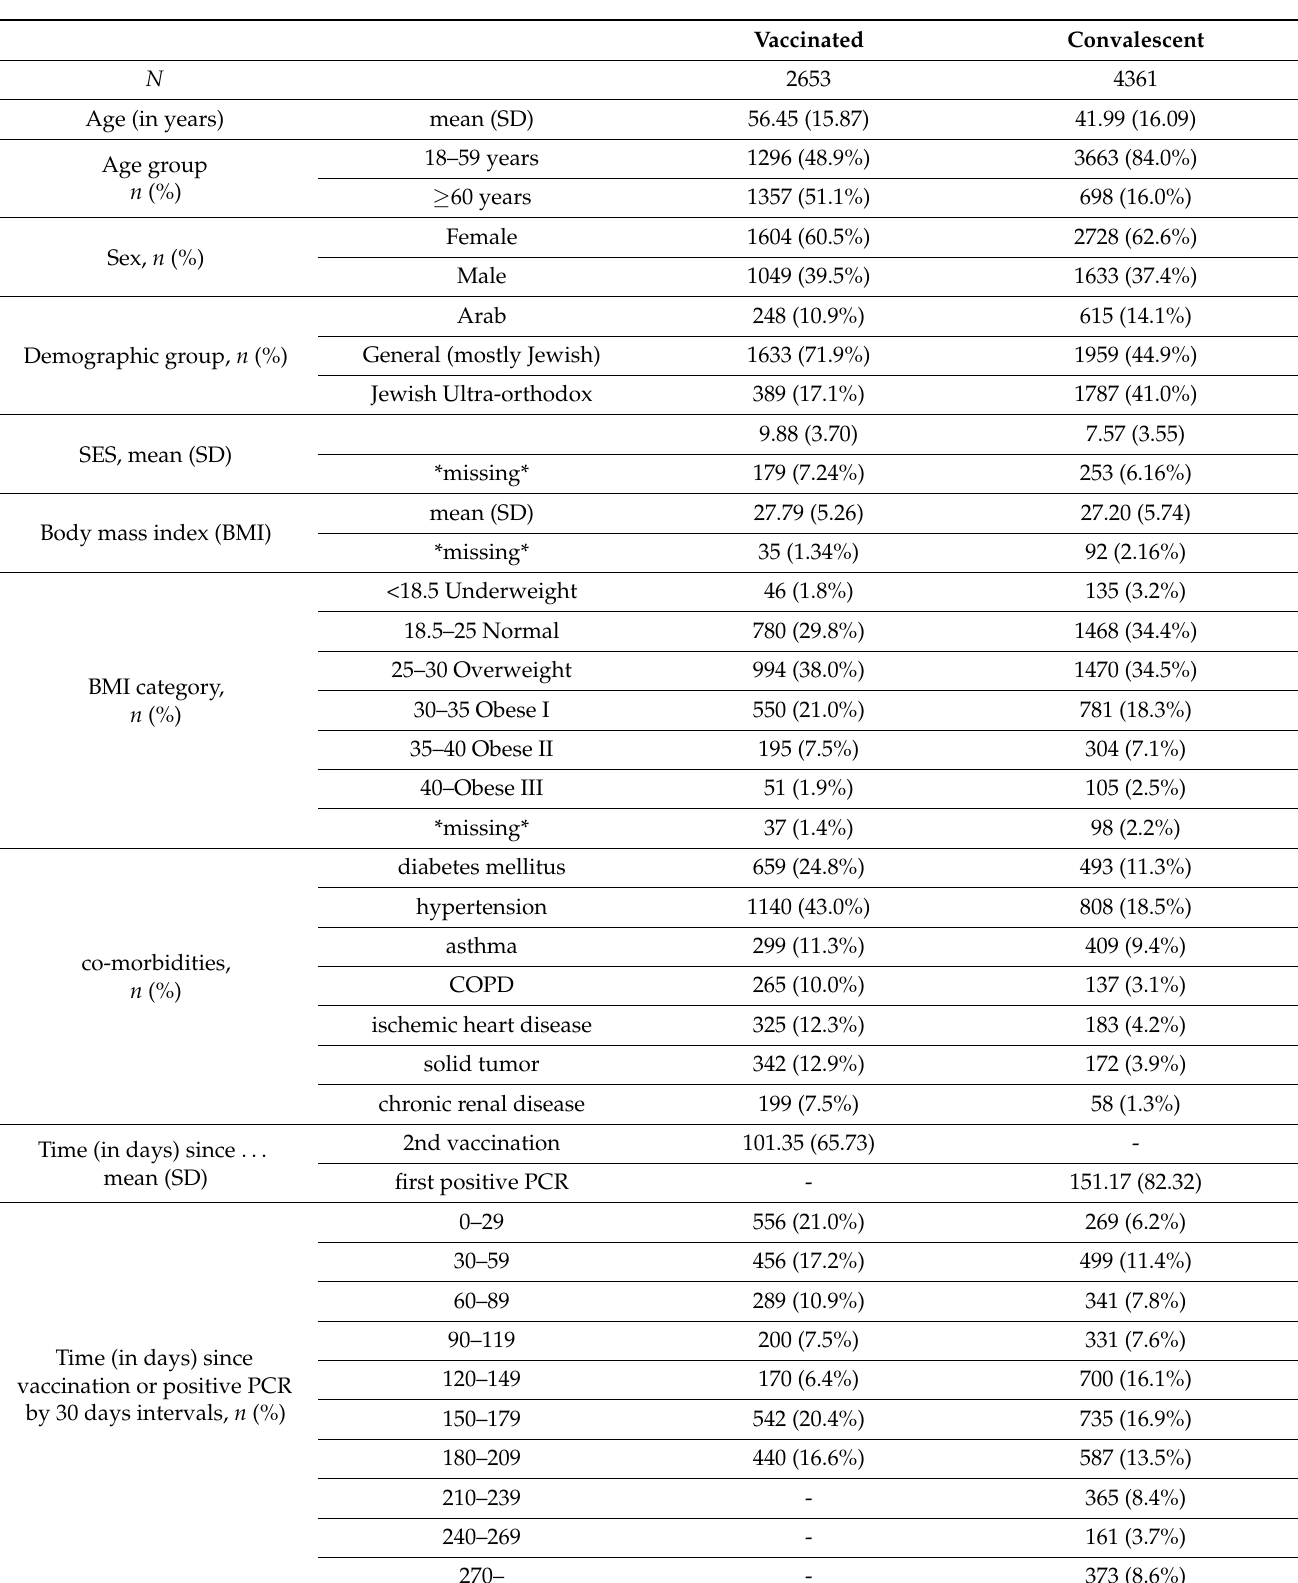
Table 1. The demographic characteristics of tested individuals in the vaccinated and convalescent